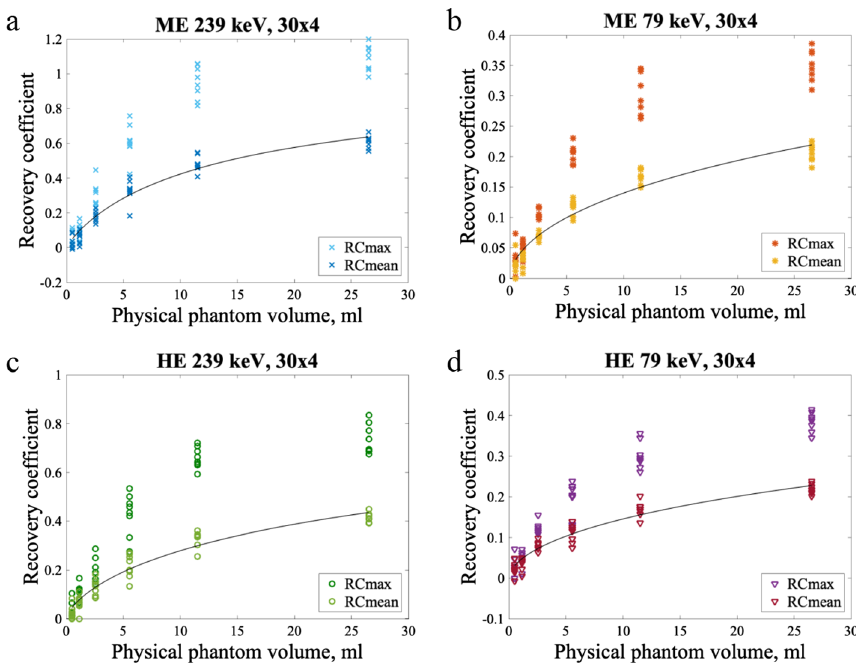
Fig. 5 RCs and curve fits for the four image protocols with the 30 filter. The equivalent figures for the other reconstructions can be found in the supplementary material. ME 239 keV is in panel a , ME 79 keV is in panel b , HE 239 keV is in panel c , and HE 79 keV is in panel d . Both RC max and RC mean data points are plotted, in addition to a curve fit to RC mean